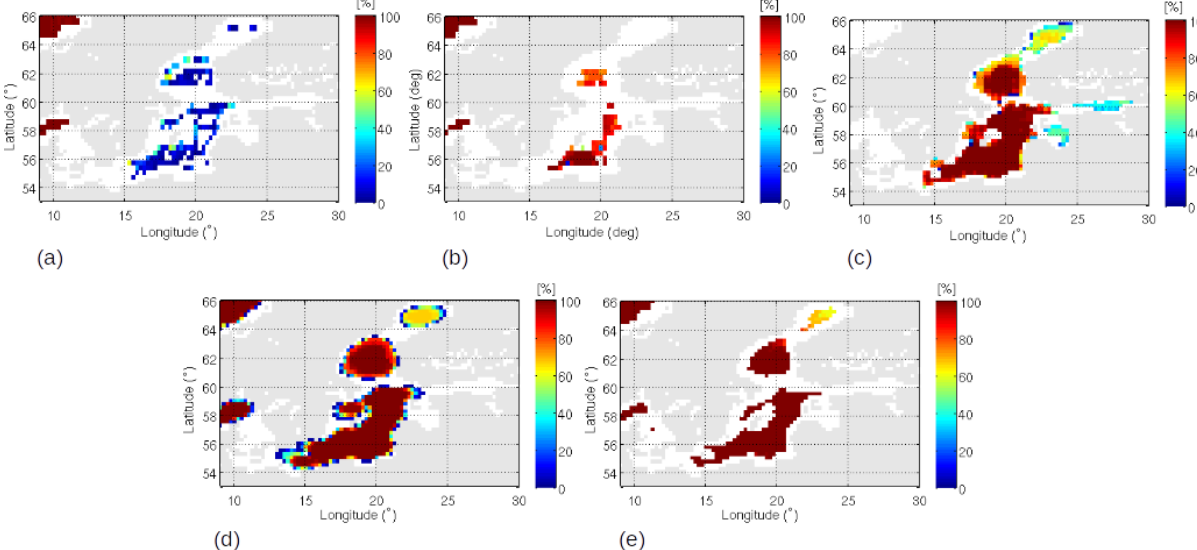
Figure 12. Spatiotemporal coverage of year 2016 (percentage of valid SSS retrievals with respect to the total number of maps in the year) for each satellite product: (a) SMOS CATDS, (b) ESA CCI, (c) Baltic+ L3 SSS, (d) SMAP JPL, (e) SMAP